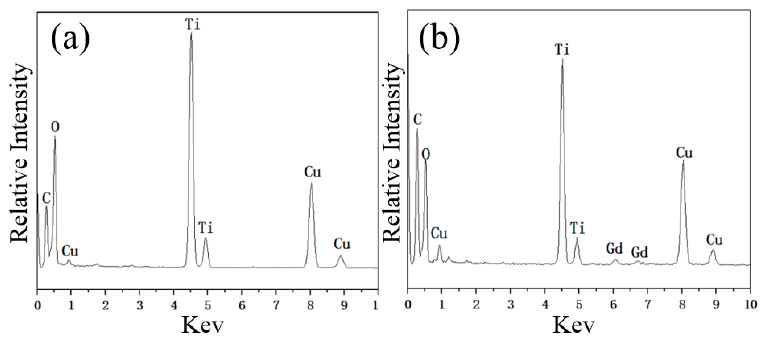
Figure 9. EDX spectra of ( a ) TiO 2 and ( b ) Gd-doped TiO 2 nanotubes